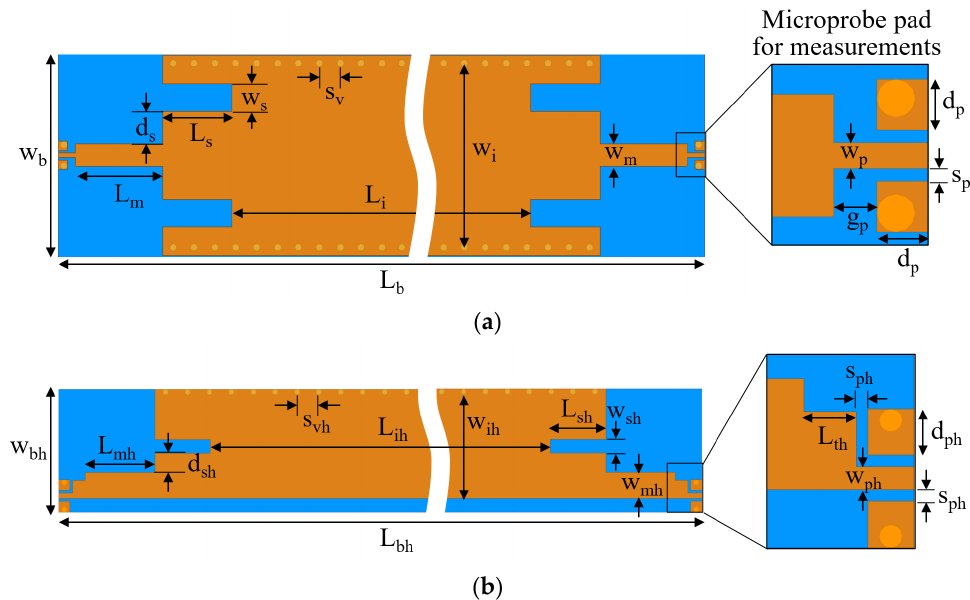
Figure 2. Fabricated TVs and their design parameters for experimental characterization. ( a ) FMSIW for TV 1 and TV 2; ( b ) HMSIW for TV 3 and TV 4. for TV 1 and TV 2; ( b ) HMSIW for TV 3 and TV